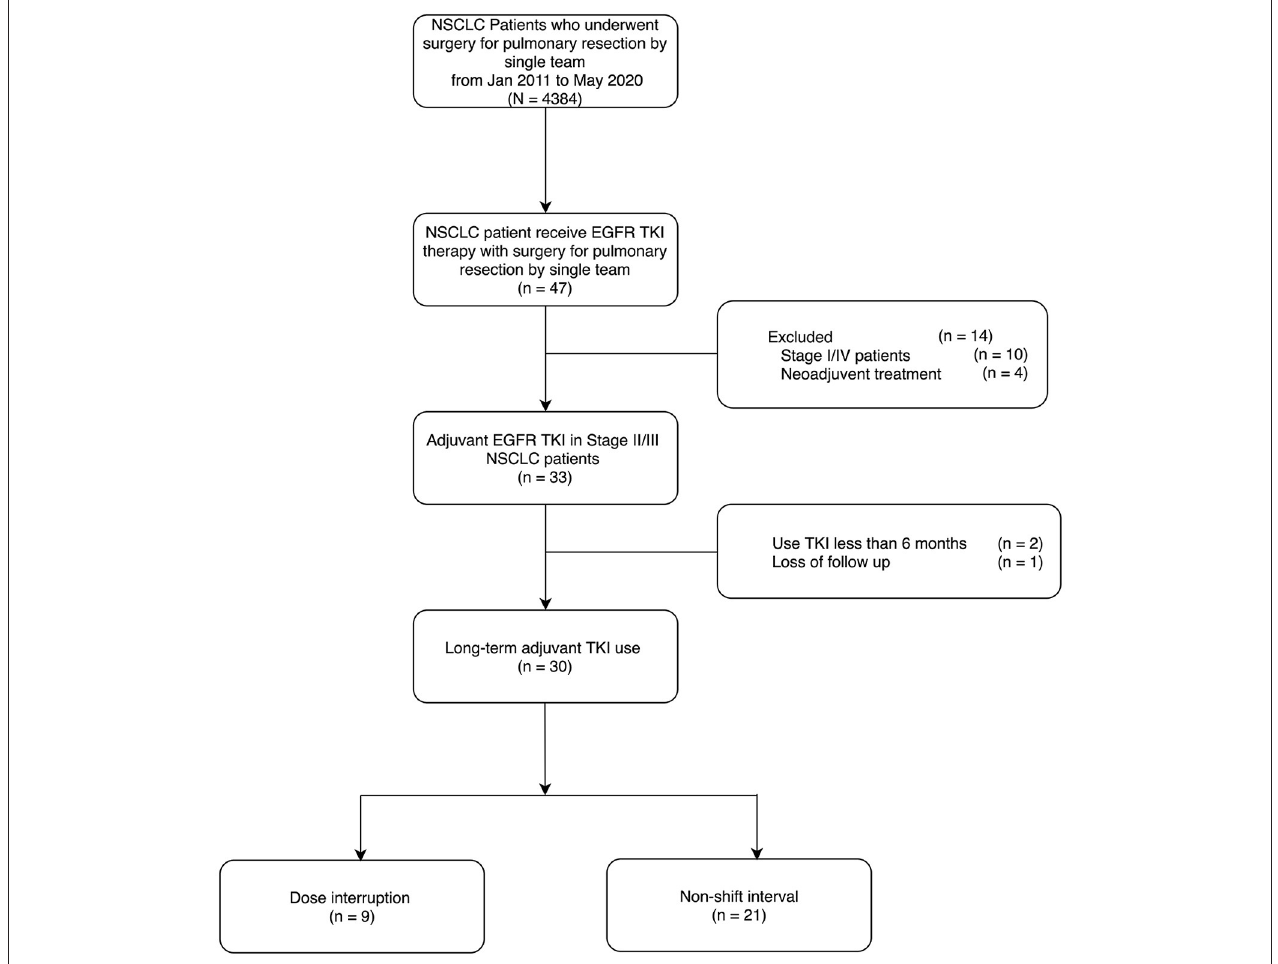
FIGURE 1 | Eligible